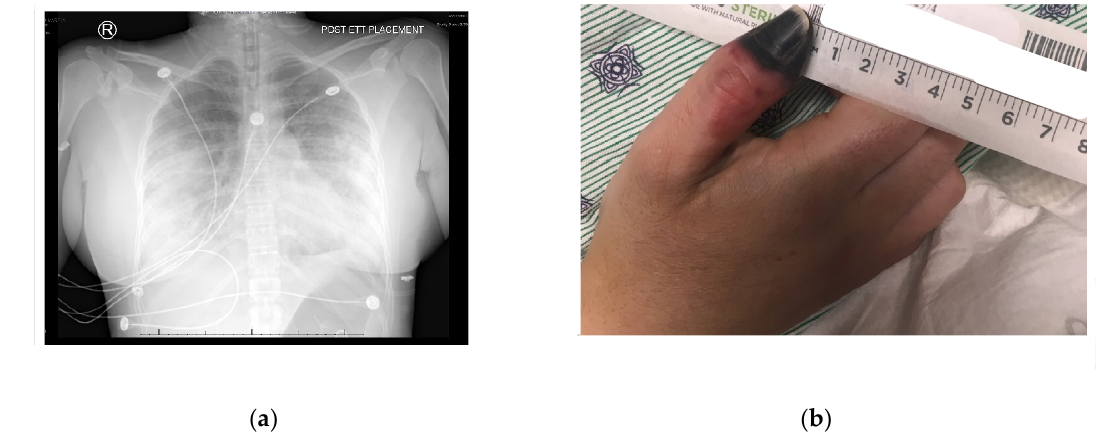
Figure 1. ( a ) Di ff use bilateral e ff usion- A / P view; ( b ) Right thumb dry Figure 1. ( a ) Diffuse bilateral effusion- A/P view; ( b ) Right thumb dry gangrene.